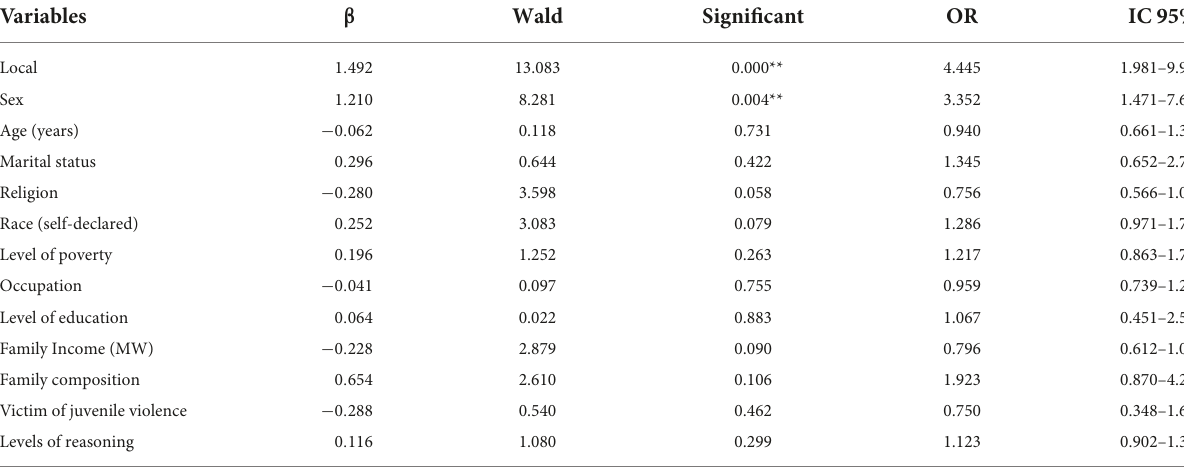
TABLE 2 Multimodal logistic regression for the “agree” opinion on reduction of the age of penal majority. Variables